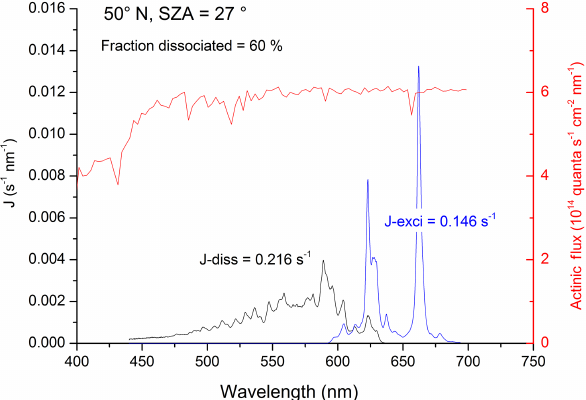
Figure 1. Rate constants for dissociative (black line, J diss ) and non-dissociative (blue line, J exci ) excitation of NO 3 . The data use solar radiation actinic flux at the surface at 50 ◦ N and a solar zenith angle (SZA) of 27 ◦ (red line) as well as the NO 3 absorp- tion cross sections and quantum yields. J values (and fraction of NO 3 dissociated) were obtained by integration of the excitation rate (quantas − 1 nm − 1 ) over the wavelength range of absorption.